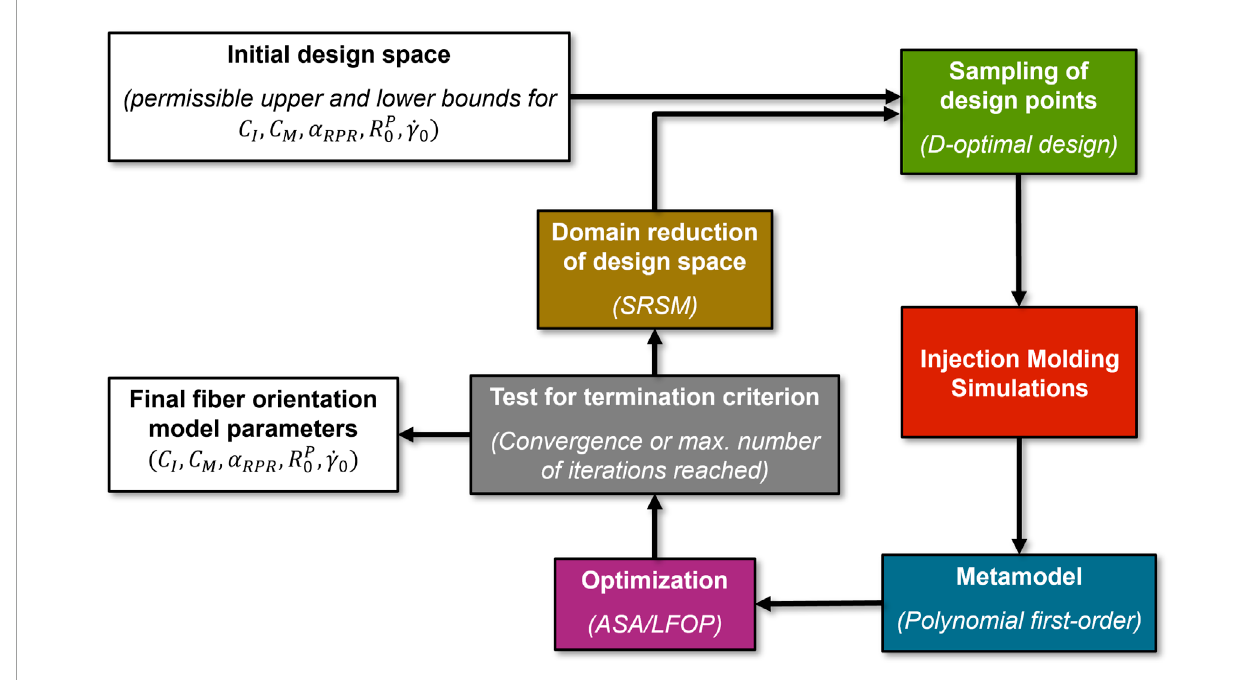
FIGURE 6 Graphical representation of the simulation methodology including the optimization cycle.